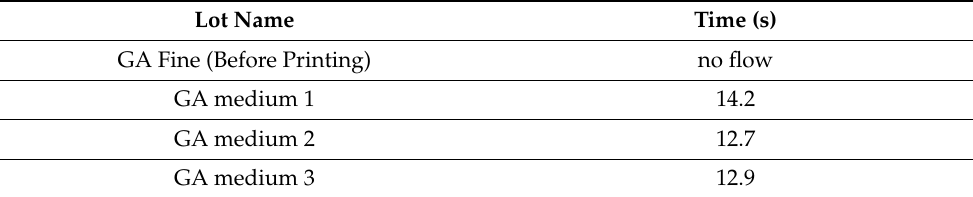
Table 2. Hall flow testing for four powder lots, averaged over three tests for each powder lot.